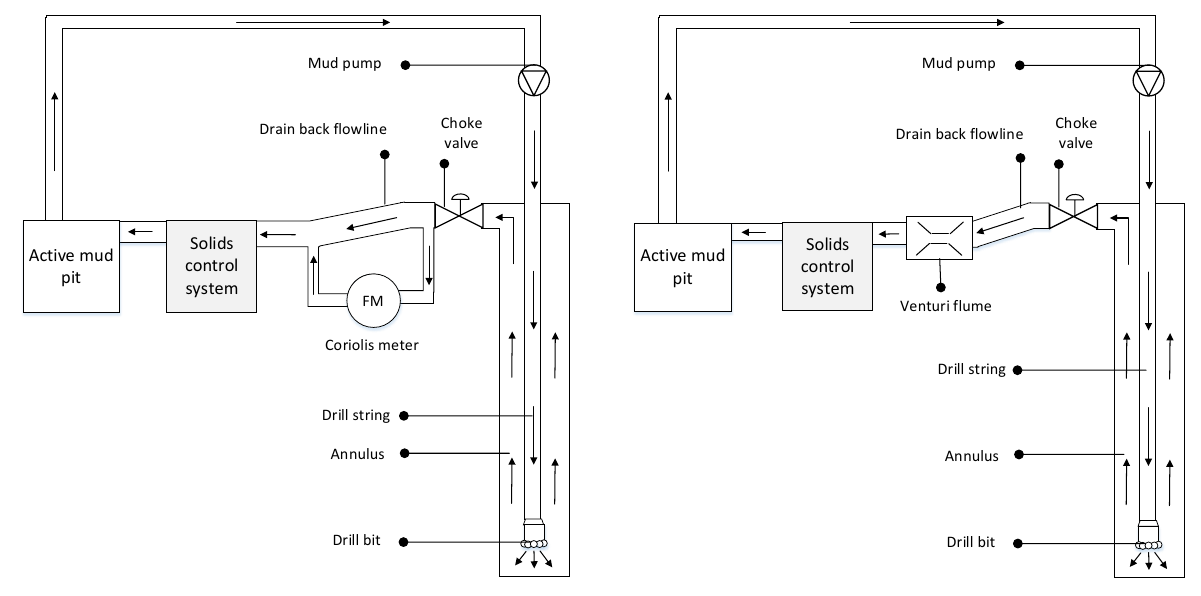
Figure 1: Drilling fluid circulating system with a Cori- olis meter